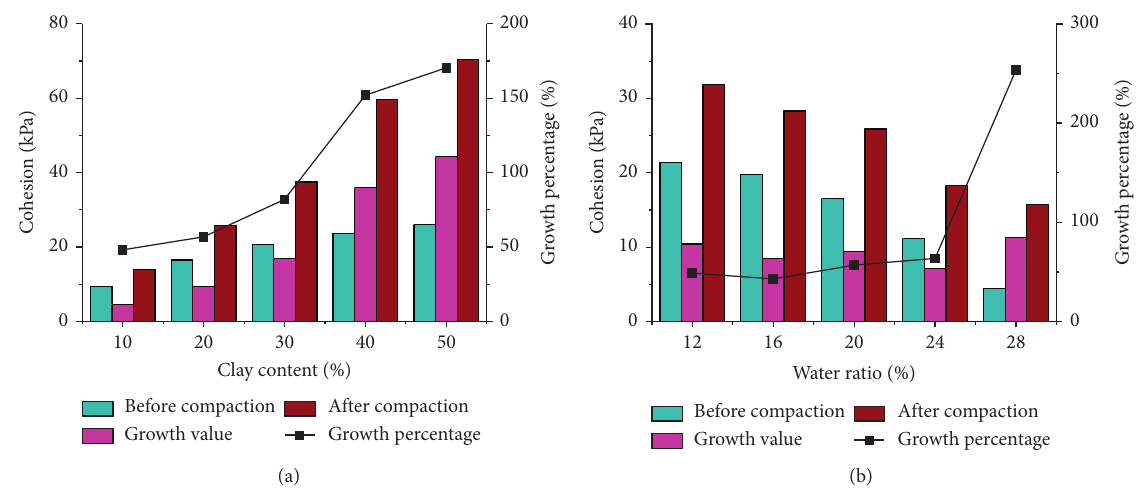
Figure 15: Comparison of cohesion before and after compaction ( p � 2MPa). (a) At different clay contents. (b) At different initial water